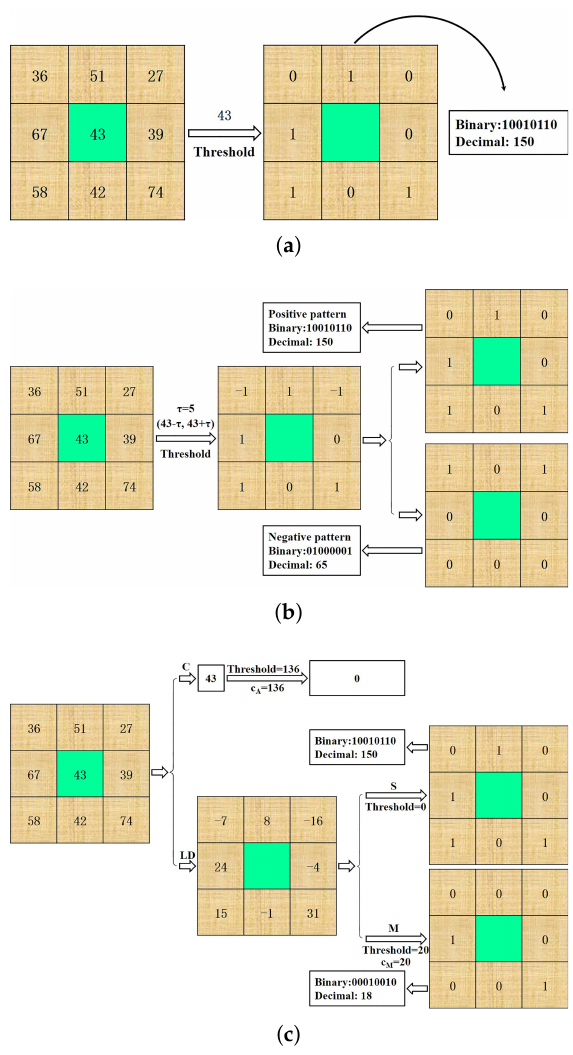
Figure 3. The encoding process of ( a ) LBP, ( b ) LTP, and ( c ) CLBP for a 3 × 3 structure.